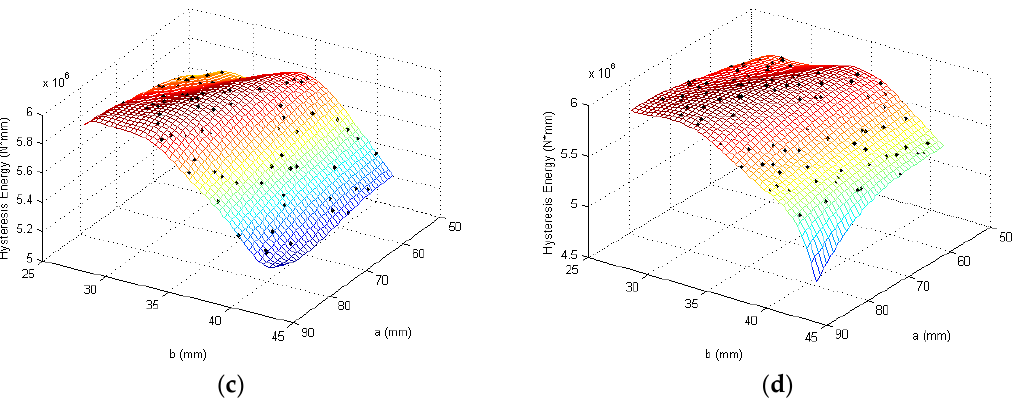
Figure 8. Kriging models with different initial samples for SP1: ( a ) 25 samples; ( b ) 50 samples; ( c ) 75 samples; and ( d ) 100 samples.